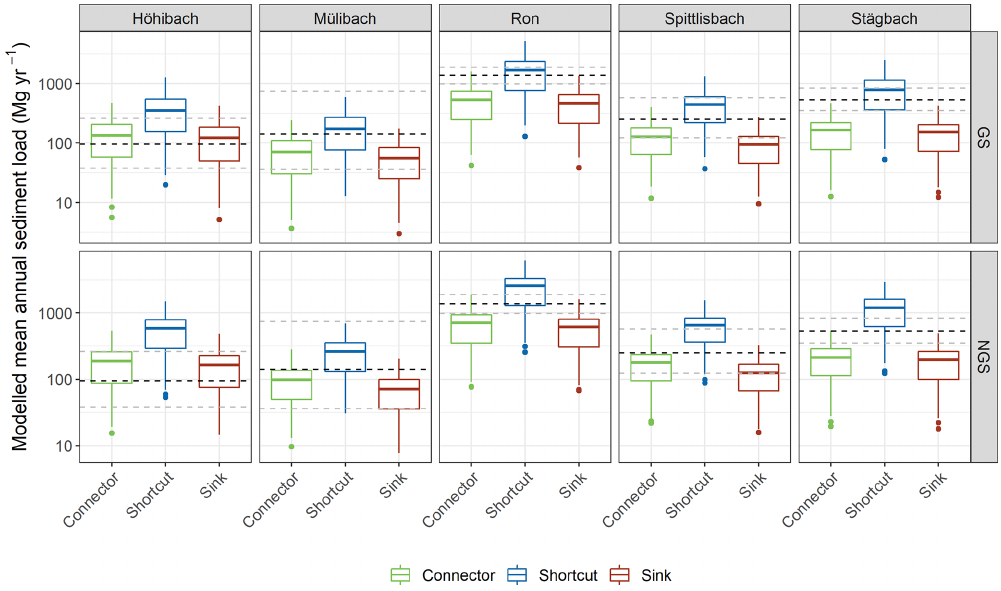
Figure 7. Box plots of hillslope sediment loads simulated by WaTEM/SEDEM for the road connectivity scenarios for each tributary sub- catchment. Dashed lines represent the median (in black) and the 95% interval (in grey) of the measurement-based estimates of sediment loads for each tributary, calculated from the error propagation of the sediment-rating curve. GS is the grass buffer strip, and NGS is the no grass buffer strips. Simulations for the shortcut scenario generally shows a higher overlap with calculated sediment loads, in particular when grass buffer strips are